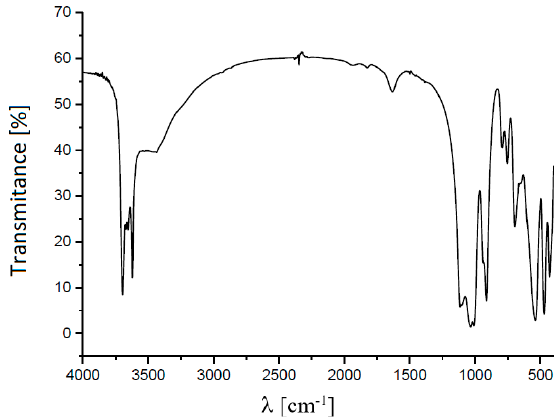
Figure 2. Fourier Transform Infrared Spectroscopy (FTIR) spectrum for kaolin powder.